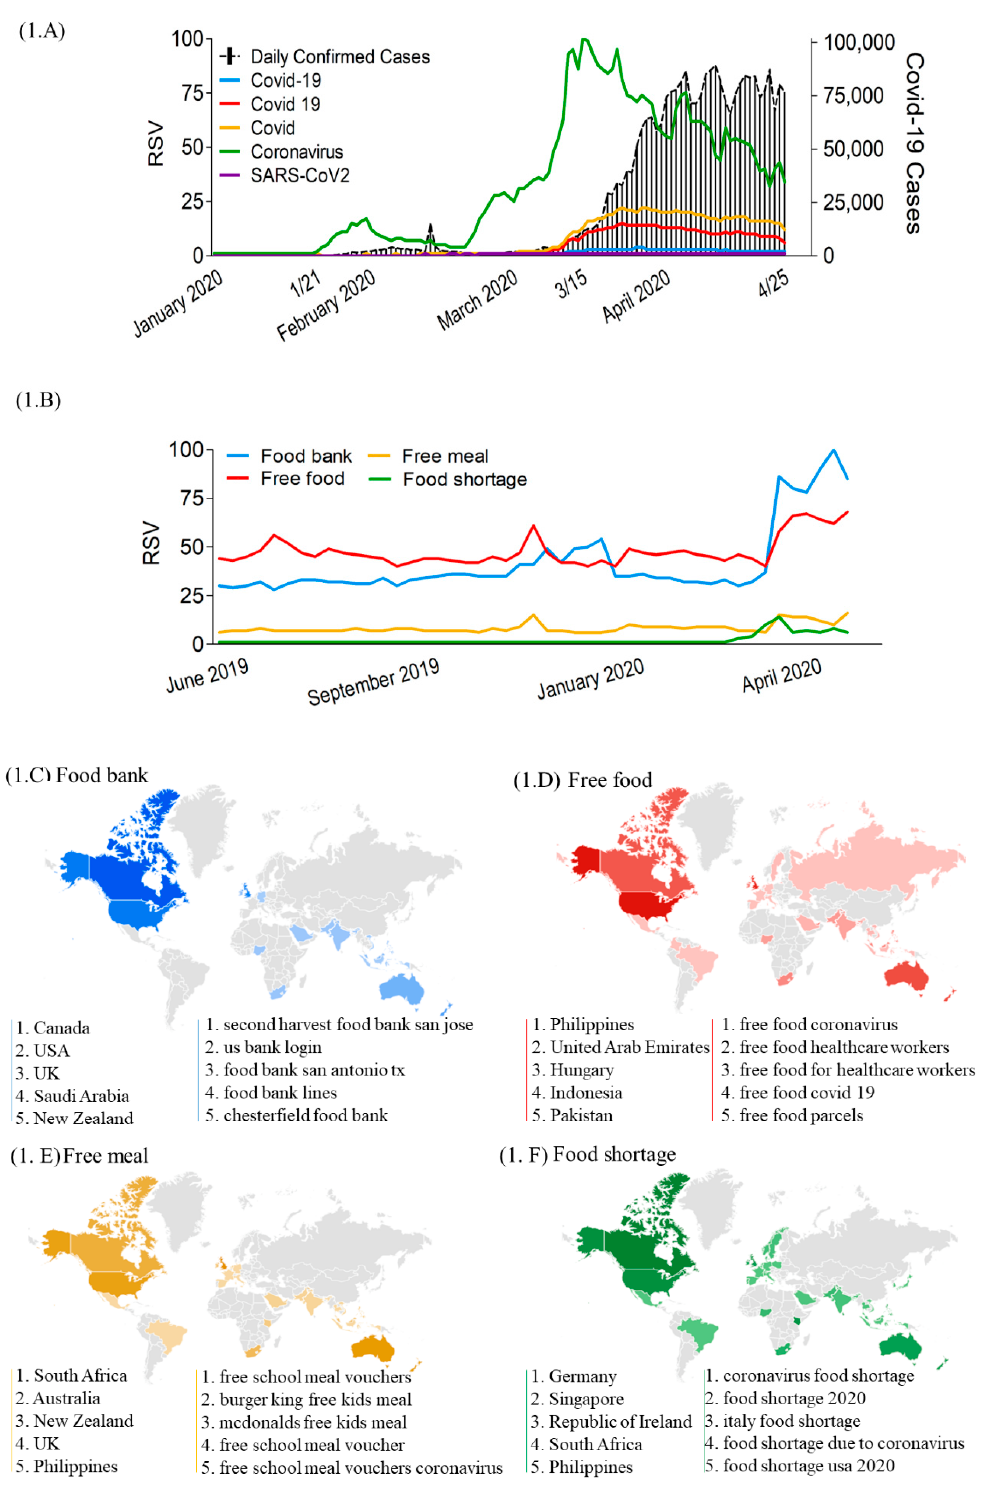
Figure 1. Global trend curves and heat map for nutrient and herb-related search terms. ( A ) Global trend curves for coronavirus-related search terms, cumulative confirmed coronavirus cases, ( B ) food insecurity RSV curves. ( C – F ) Indicates food insecurity interest heat map covering from 31 December 2019 to 25 April 2020: ( C ) Food bank, ( D ) Free food, ( E ) Free meal, ( F ) Food shortage. ( C – F ) The left line indicates the top five searched countries and the right line indicated the top five rising queries related search term. RSV: relative search volumes.